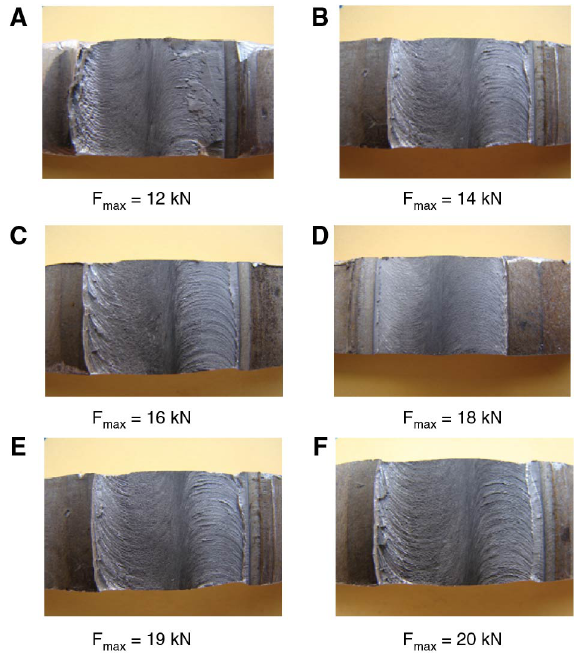
Figure 11: Photographs of failed T-joint specimen at R = 0.